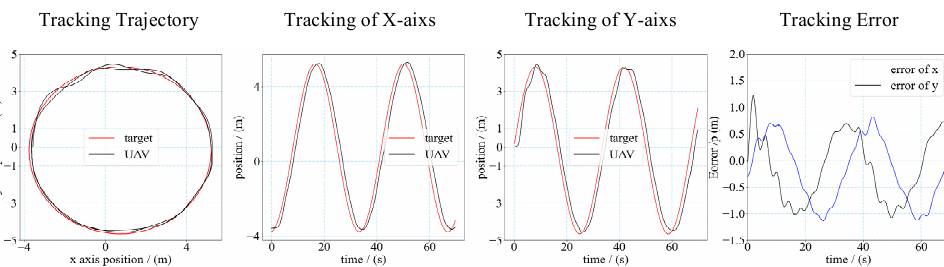
Figure 15. The real-world environment of the flight test.